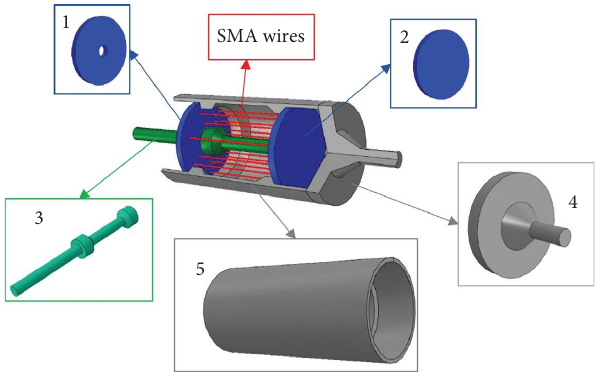
Figure 10: Assembling of the suggested